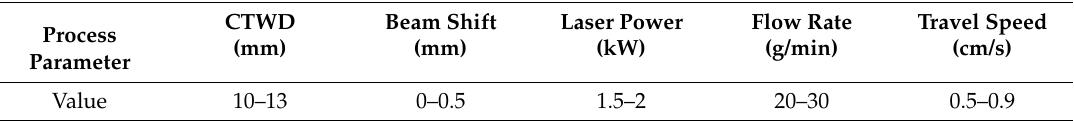
Table 5. Optimized process parameters for the defect-free cladding bead by using irregular shaped powder. CTWD—contact tip to work-piece distance.